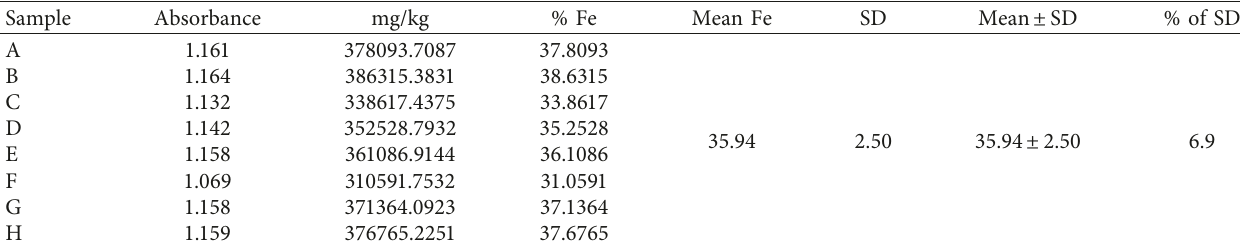
Figure 5: (a) Color development of potassium hexathiocyanatoferrate (III). (b) Determination of λ using its 2.5-ppm solution. (c) Calibration curve for determination of Fe (III) in the form of Fe (SCN) 3 by UV spectroscopic method. (d) Amount of Fe in the given ore by UV spectroscopic method. Table 5: Iron content values of different samples of hematite ore determined by the measurement of absorption using spectrophotometer. The mean value in the table represents the mean of samples for each channel assigned from A to H.